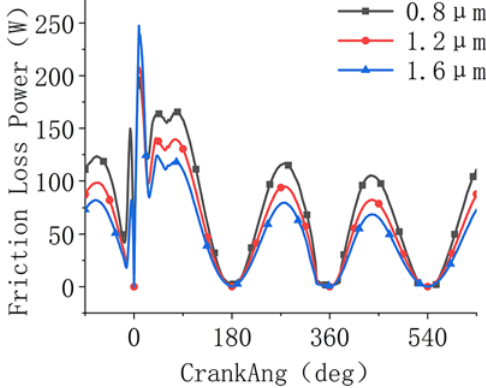
Fig. 15. Top ring roughness friction loss relationship curve.